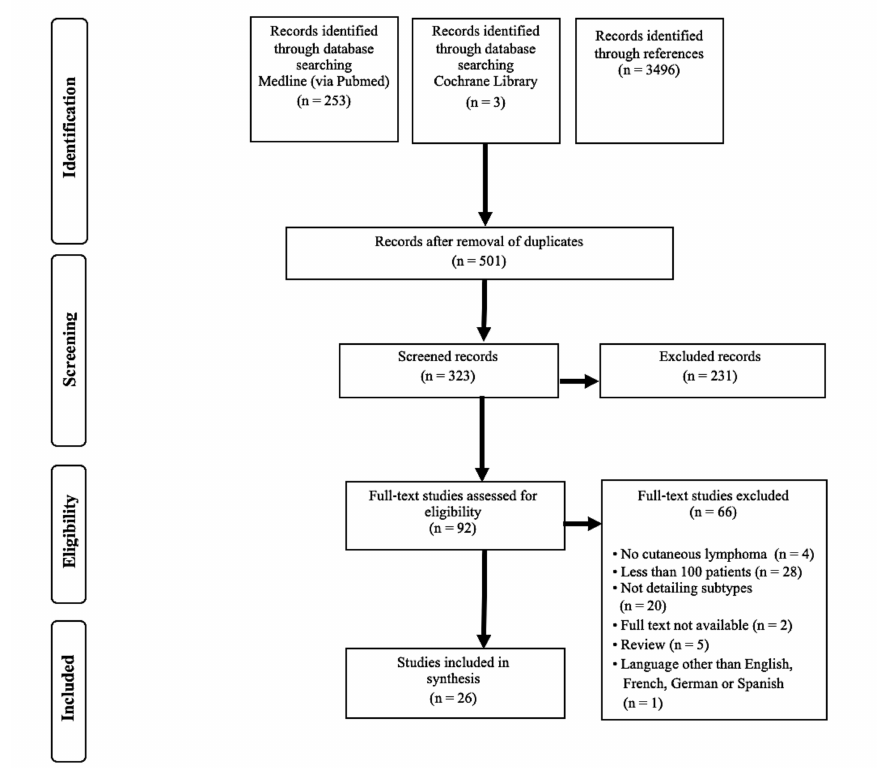
Figure 1. Flowchart of study selection according to the preferred reporting of items for systematic reviews and meta-analyses (PRISMA).